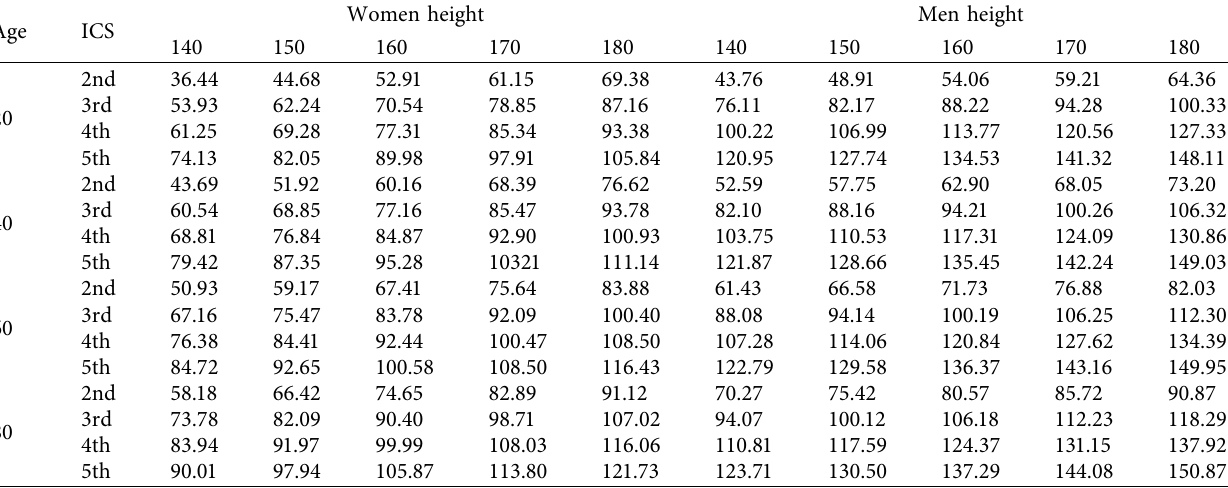
Table 5: Weight chart for Model 1; women: left panel; men: right panel.